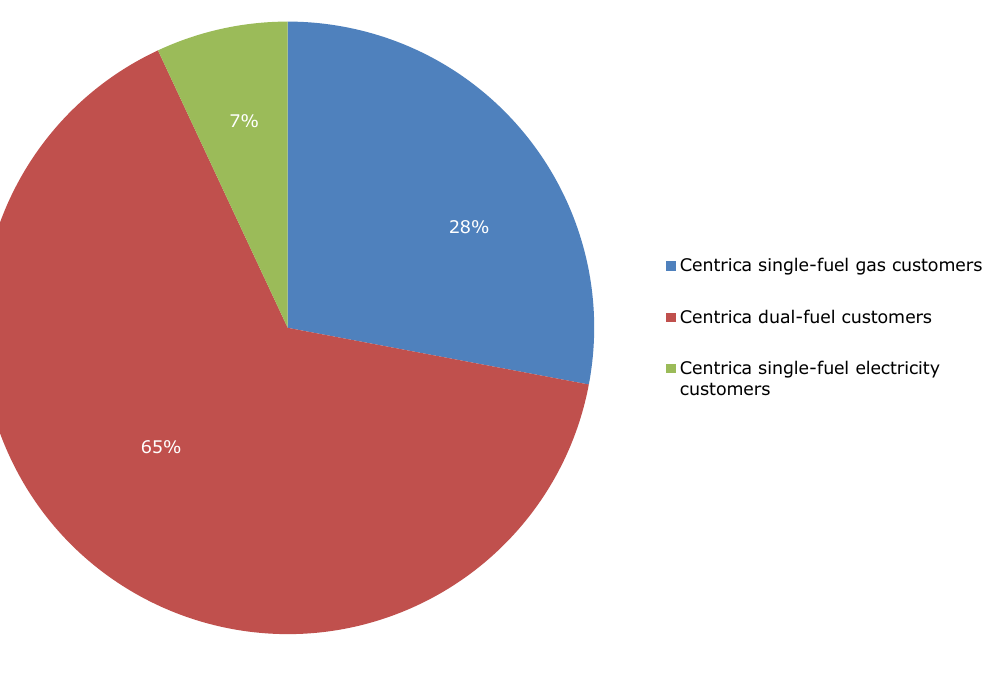
Figure 19: Composition of Centrica’s customer